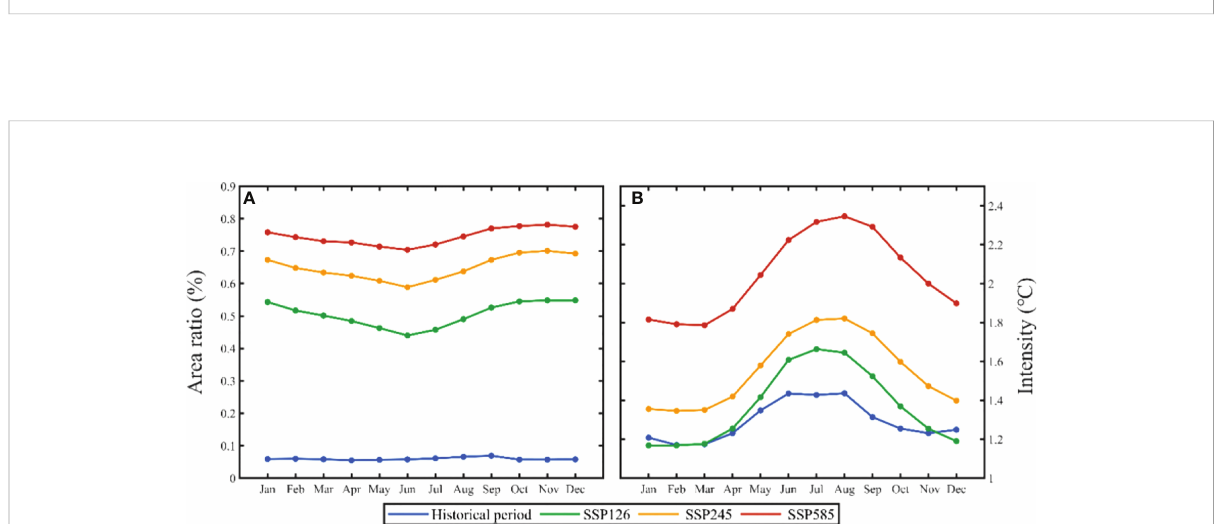
FIGURE 14 Monthly distribution of MHWs occurrence area percentage (A) and MHWs mean intensity (B) in the WNPCC area. The blue, green, yellow, and red curves represent the historical period, and the projection period under the SSP1-2.6, 2-4.5 and 5-8.5 scenarios,